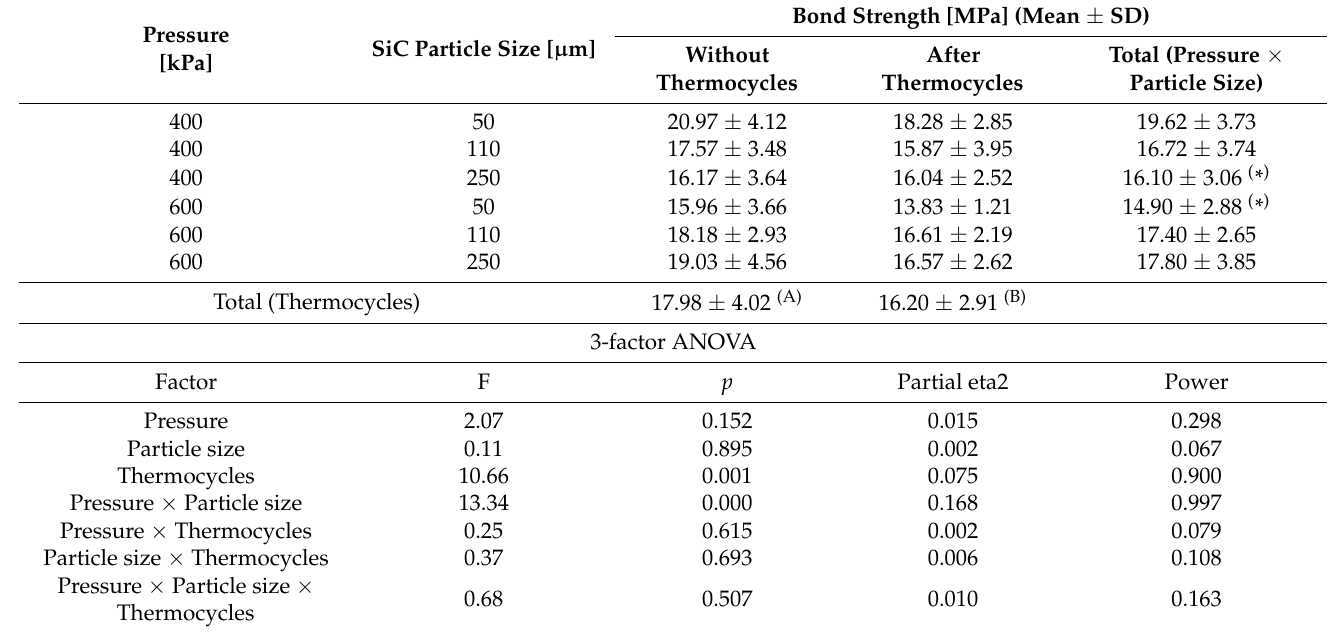
Table 4. Results of the shear strength measurements of the Ni-Cr alloy-dental ceramic